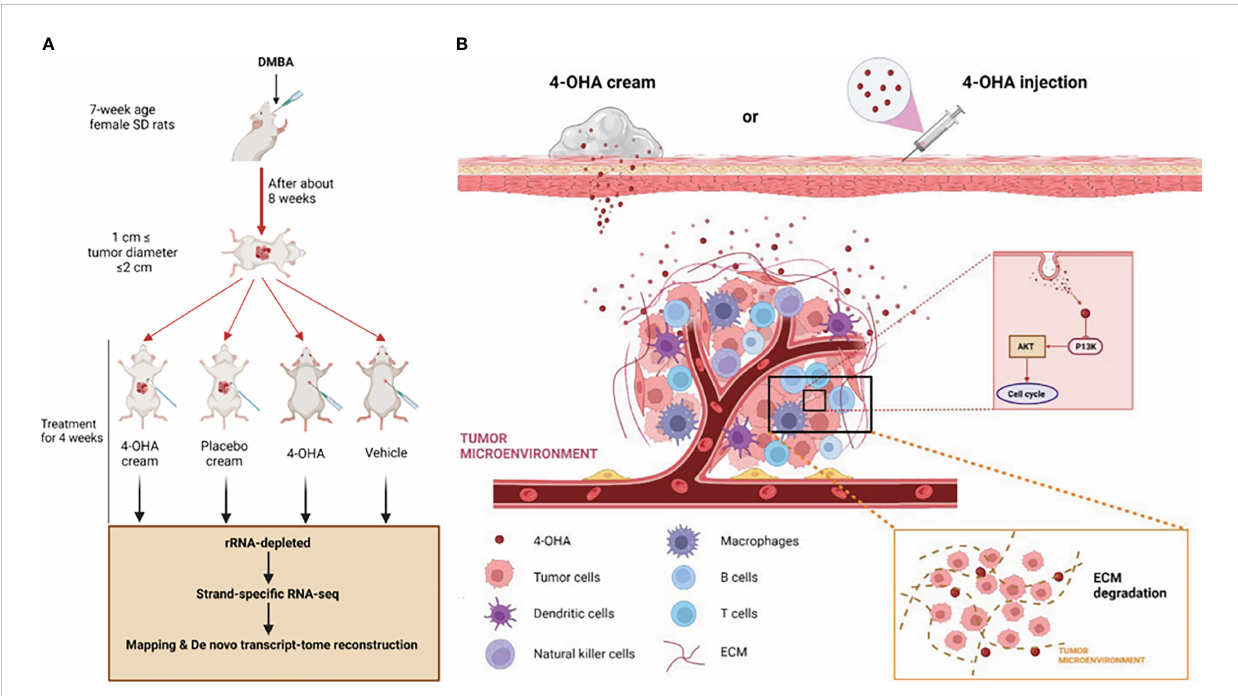
FIGURE 1 Study design and mechanism of 4-OHA cream anti-breast cancer. Study design. Mammary tumors were initiated with DMBA at PND 49, and when the fi rst tumor per rat reached a size of 1.5 cm in diameter but less than 2 cm, 4-OHA was given to the rats as indicated in the Materials and Methods. (A) Tumors responding to 4-OHA were harvested for RNA-seq. (B) The mechanism of action of 4-OHA